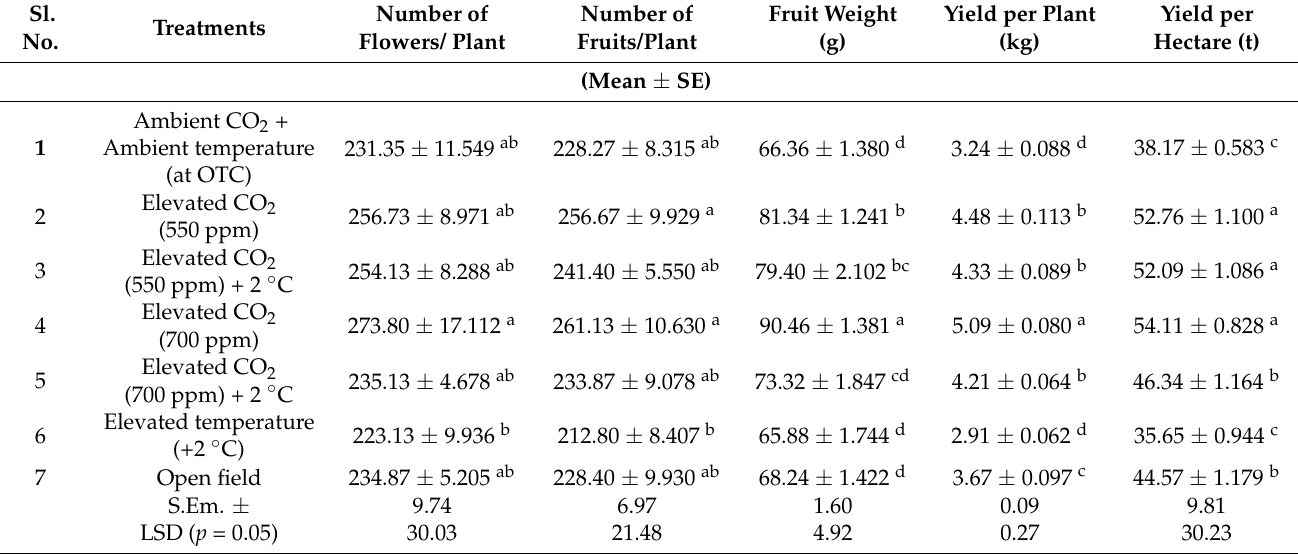
Table 2. Number of flowers, fruits per plant, fruit weight (g), yield per plant (kg) and yield per hectare (t) of tomato as influenced by elevated CO 2 and temperature